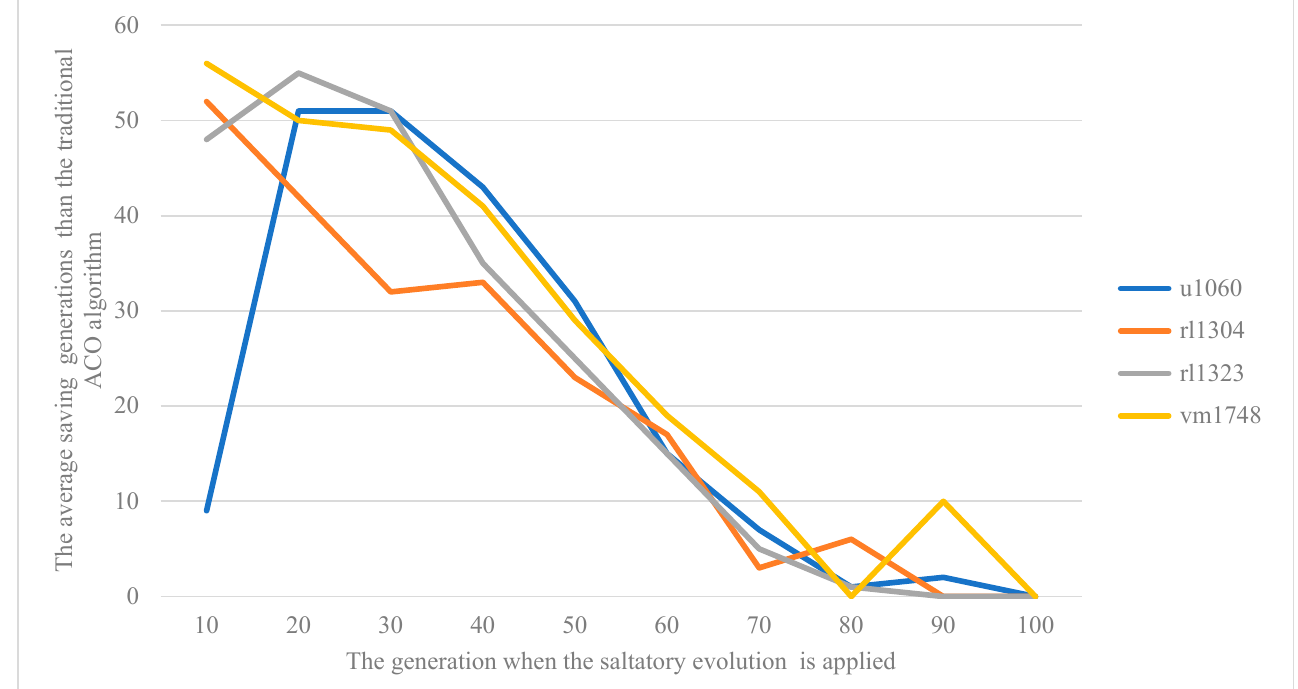
Figure 8. The optimization results of SEACO algorithm for data sets where n is in [400, 800].